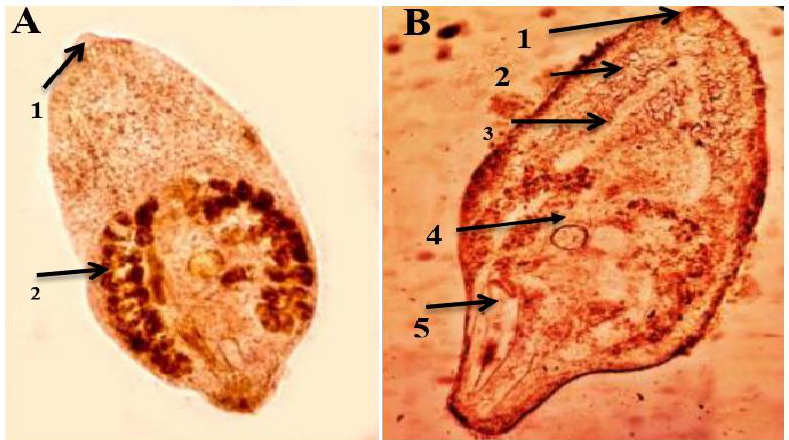
Figure 5. Adult recovered from experimental infection of mice with encysted metacercariae under light microscope. ( A ) Prohemistomum vivax adult stage × 100 (1—oral sucker, 2—horseshoe-shapes vitelline glands); ( B ) Mesostephanus spp. × 100 (1—oral sucker, 2—horseshoe-shapes vitelline glands,